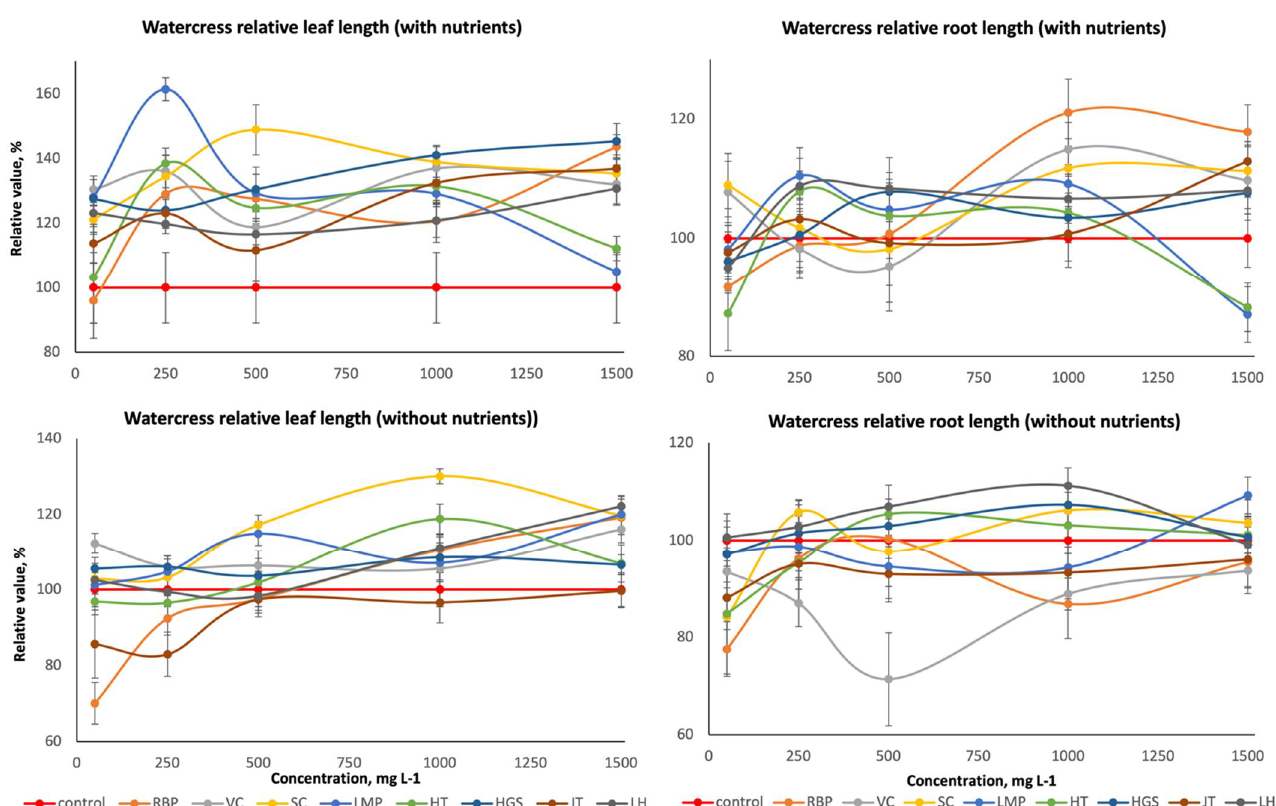
Figure 3. Relative changes in watercress ( Lepidium sativum ) shoot and root length over a concentration range of potassium humate solutions of different origins, with and without added nutrient solution. RBP = raised bog peat, VC = vermicompost, SC = soil compost, LMP = low moor peat, HT = Humin Tech potassium humate, HGS = Humic Growth Solutions potassium humate, JT = Jin Tai FA, LH = Lignohumate HS.